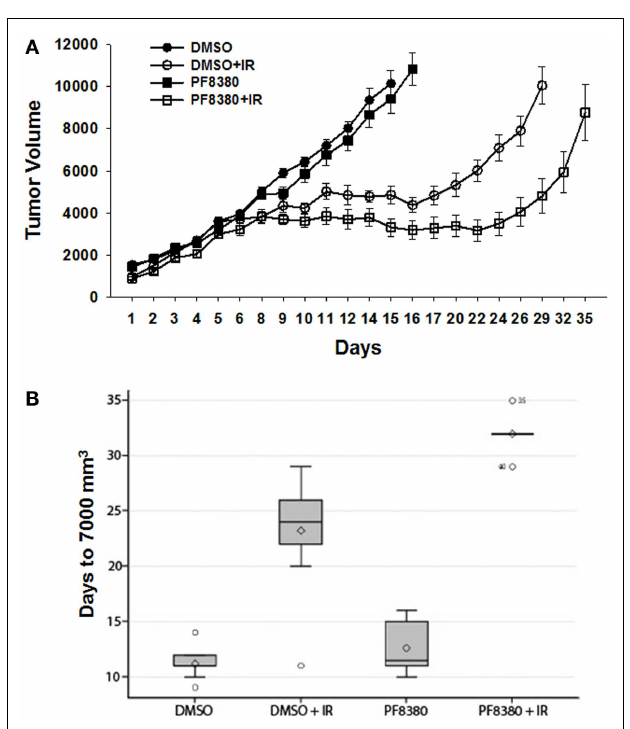
FIGURE 6 | Inhibition ofATX in combination with irradiation delays tumor growth in a heterotopic tumor model of GL261 . GL261 cells were implanted into the hind limbs of nude mice. Mice were treated for five consecutive days with PF-8380 or vehicle control prior to irradiation.Tumors were irradiated with 2Gy for five consecutive days for a total of 10Gy. Shown is a line graph depicting the mean tumor volumes with SEM from each treatment group of 10 mice * p < 0.05 (A) .The box plot depicting the tumor growth delay calculated as the number of days for tumors to reach 7000mm 3 (B)